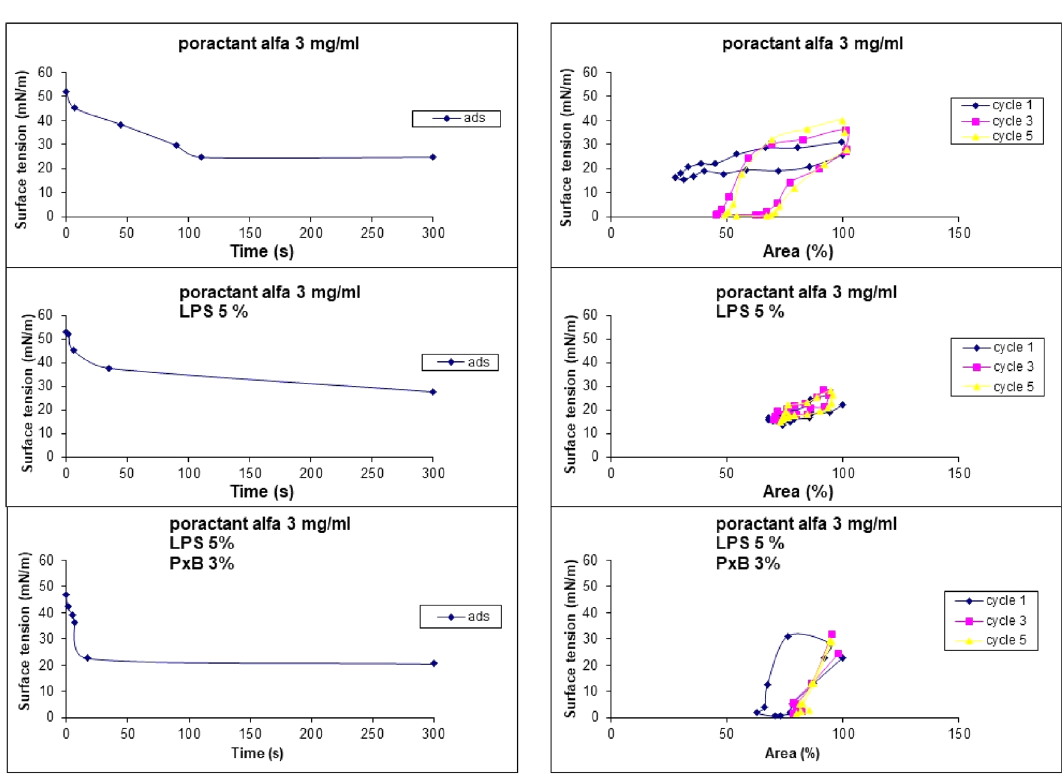
Figure 3. Representative diagrams of the behavior of the poractant alfa at 3 mg/ml (up), poractant alfa 3 mg/ml and 5% LPS (middle) and poractant alfa 3 mg/ml, 5% LPS and 3% PxB (down) in captive bubble surfactometer. Speed of absorption at the surface of the air bubble (left) and surface tension at 1st, 2nd and 5th cycle during compression